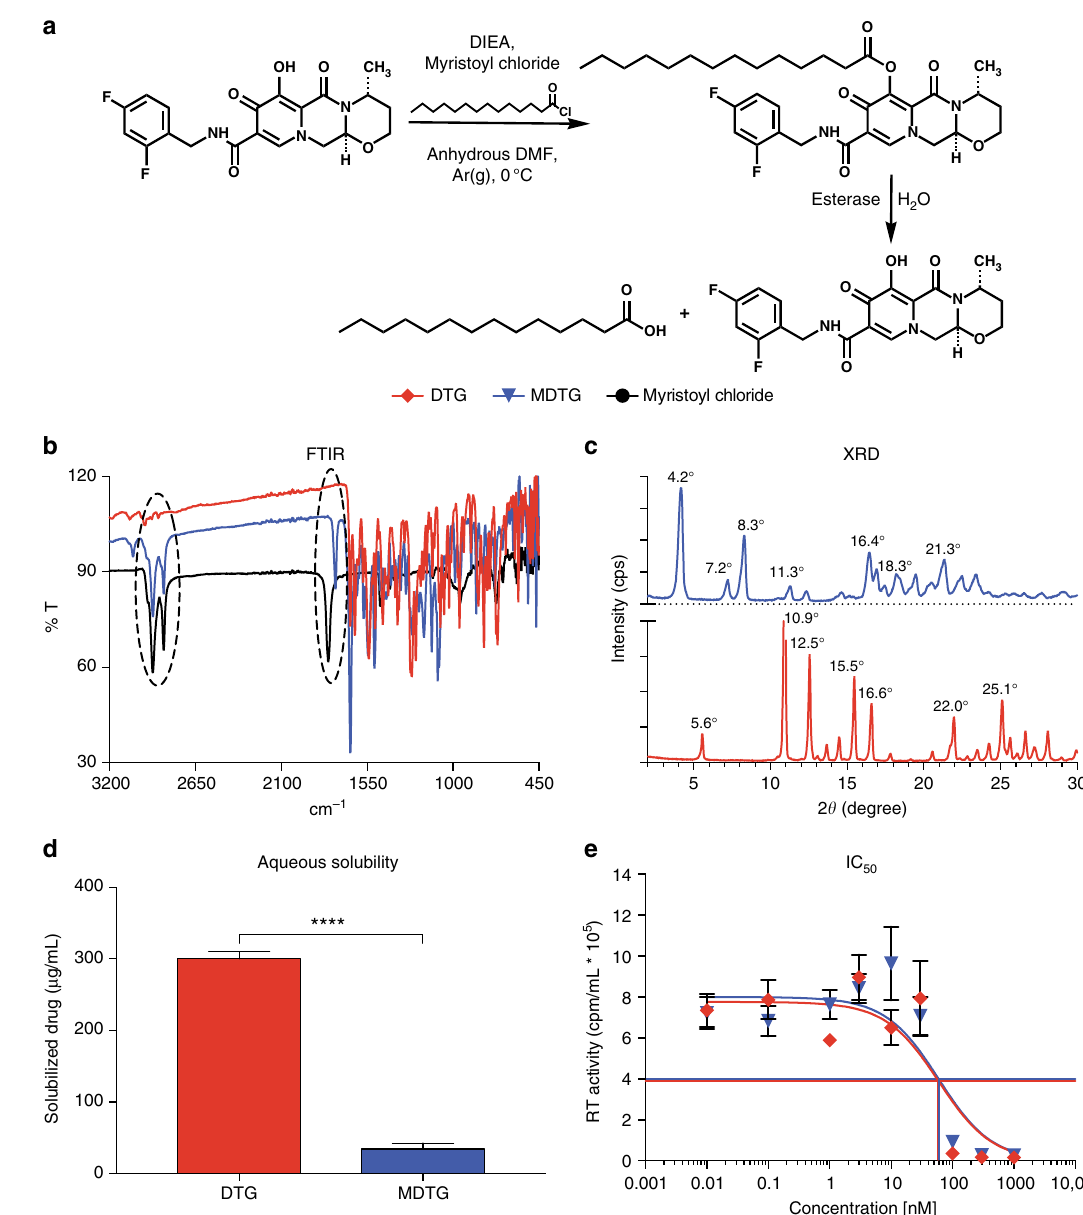
Fig. 1 Synthesis and characterization of MDTG. a A fourteen-carbon fatty-acid modi fi ed DTG prodrug (MDTG) was synthesized creating hydrophobic crystals at a fi nal drug yield of 82.8%. b Absorption bands at 2915 cm − 1 and 2850 cm − 1 in the MDTG Fourier-transformation infrared spectrum (FTIR) illustrate the methyl C – H asymmetric and symmetric stretching of the myristic acid alkyl group. Bands at 1795 cm − 1 in the myristoyl chloride and 1750 cm − 1 in the MDTG FTIR spectrum correspond to carbonyl C = O stretching of the myristic acid acyl halide that reacts as the ester is formed in MDTG. c X-ray diffraction (XRD) analysis for DTG and MDTG demonstrates the crystalline structures of both drugs. d Aqueous solubility of DTG and MDTG demonstrates the decreased solubility of MDTG. **** P < 0.0001 DTG vs. MDTG. e IC 50 was determined in vitro in MDM by HIV-1 RT inhibition after DTG and MDTG treatment over a range of concentrations (0.01 – 1000 nM). Chemical modi fi cation of DTG did not affect antiretroviral drug activity (56.7 nM and 62.5 nM for DTG and MDTG, respectively; P = 0.8397). Results are shown as the mean ± SEM of three replicates. Results from d were analyzed by two-tailed Student ’ s t test ( n = 10 DTG, 12 MDTG; t = 20.1, degrees of freedom = 20). Results from e were analyzed by nonlinear regression least squares